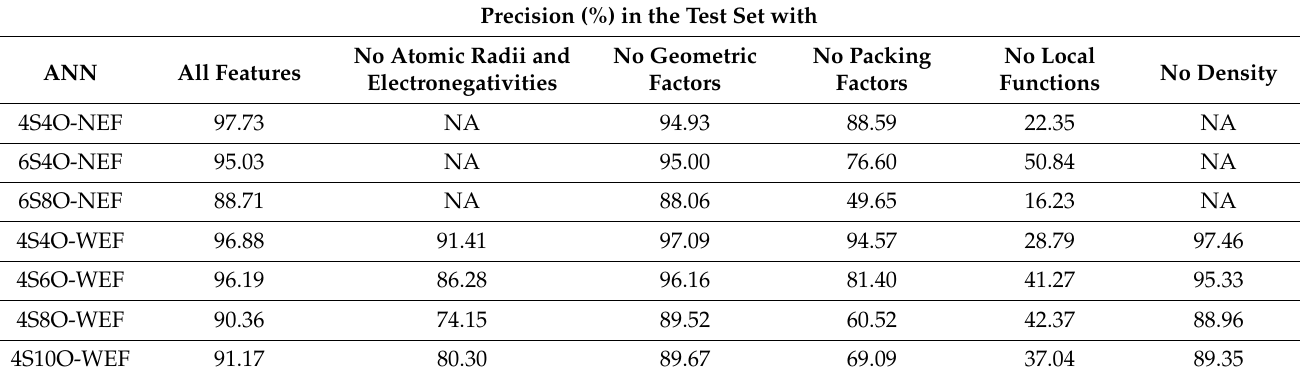
Table 5. Precision of each developed ANN after hiding features according to Figure 2. The precision obtained in this table were computed after the compounds in the first test